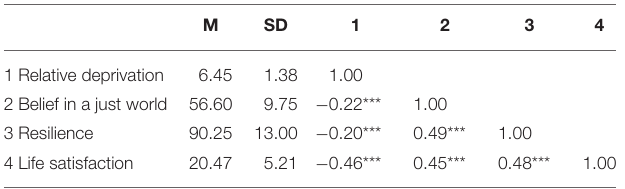
TABLE 1 | Pearson’s correlations among the study